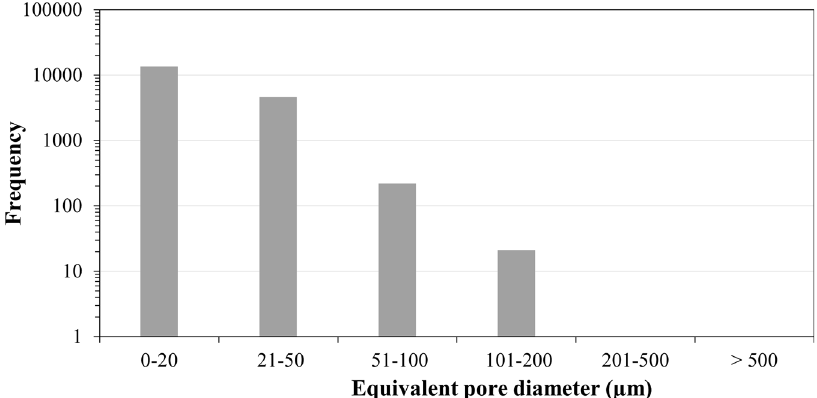
Fig. 3 Pore size distribution for MCCI-simulant mechanically tested on I12 beamline at the Diamond Light Source